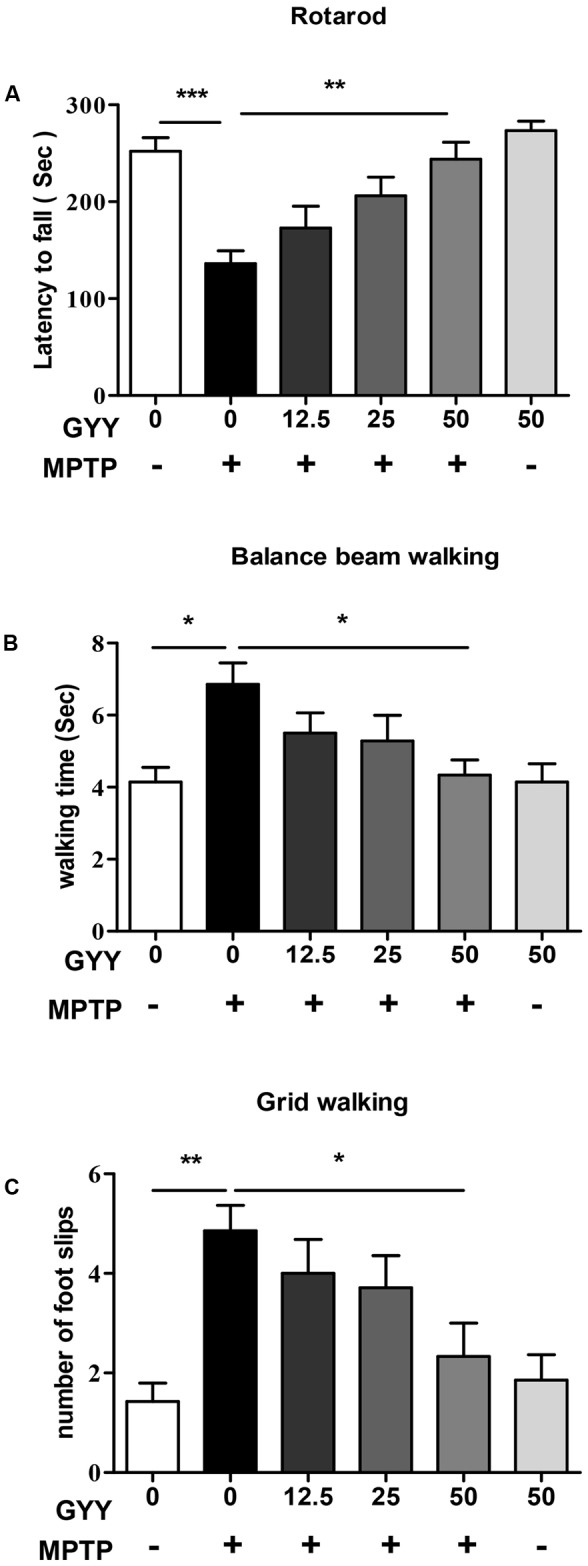
GYY ameliorated motor deficits in MPTP-induced mouse model of PD. Performance on the rotarod (A) and balance beam (B) was impaired by MPTP administration, as indicated by a shorter latency to stay on the rod (A) and a longer period to cross the beam (B) in MPTP-injected mice. The number of foot slips in the hindpaw (C) was also increased by MPTP injection compared to controls. GYY (12.5, 25, and 50 mg/kg/d, i.p.), administered 3 days before and 2 weeks after MPTP injection, alleviated the MPTP-induced motor dysfunction to a different extent, and the effect of 50 mg/kg GYY was consistently significant. Treatment with 50 mg/kg GYY or saline alone did not affect the motor behavior. Results are presented as mean ± SEM from 6 to 7 mice per group. ∗P < 0.05, ∗∗P < 0.01, ∗∗∗P < 0.001; one-way ANOVA.